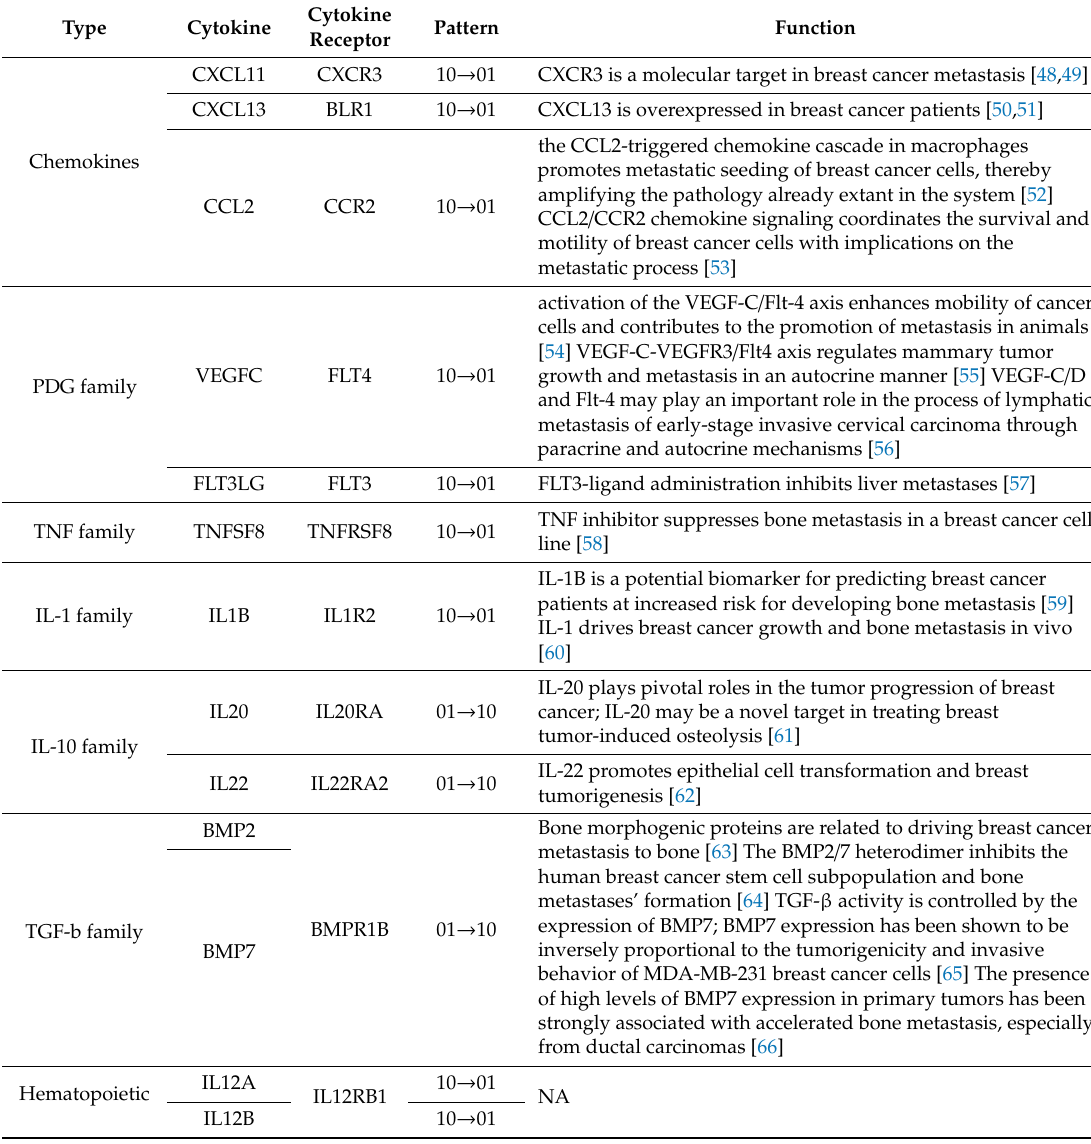
Table 2. Literature verification for the 13 cytokine-cytokine receptor